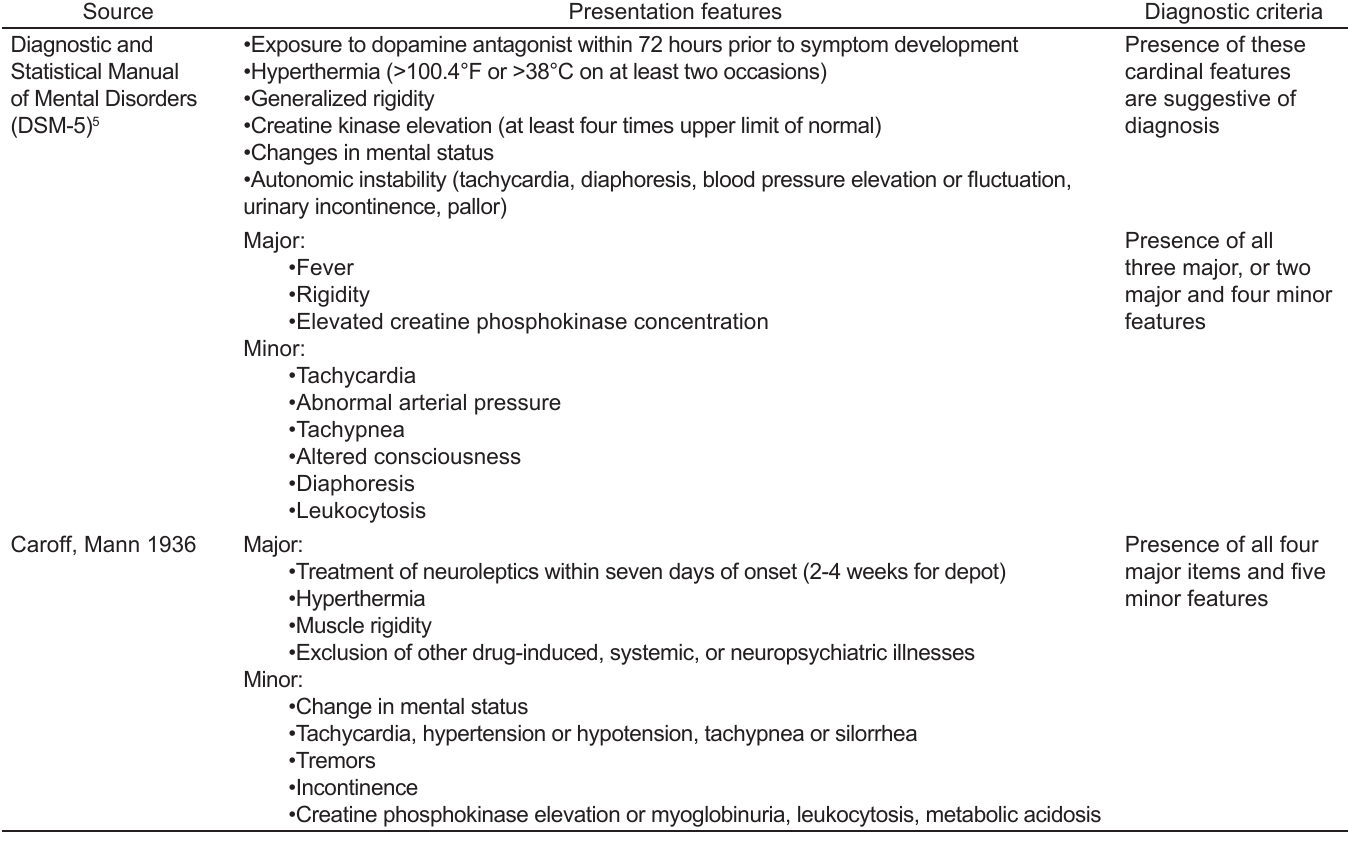
Table 1. Diagnostic criteria via Diagnostic and Statistical Manual of Mental Disorders (DSM-5), 5 Levenson, 4 and Caroff and Mann. 6